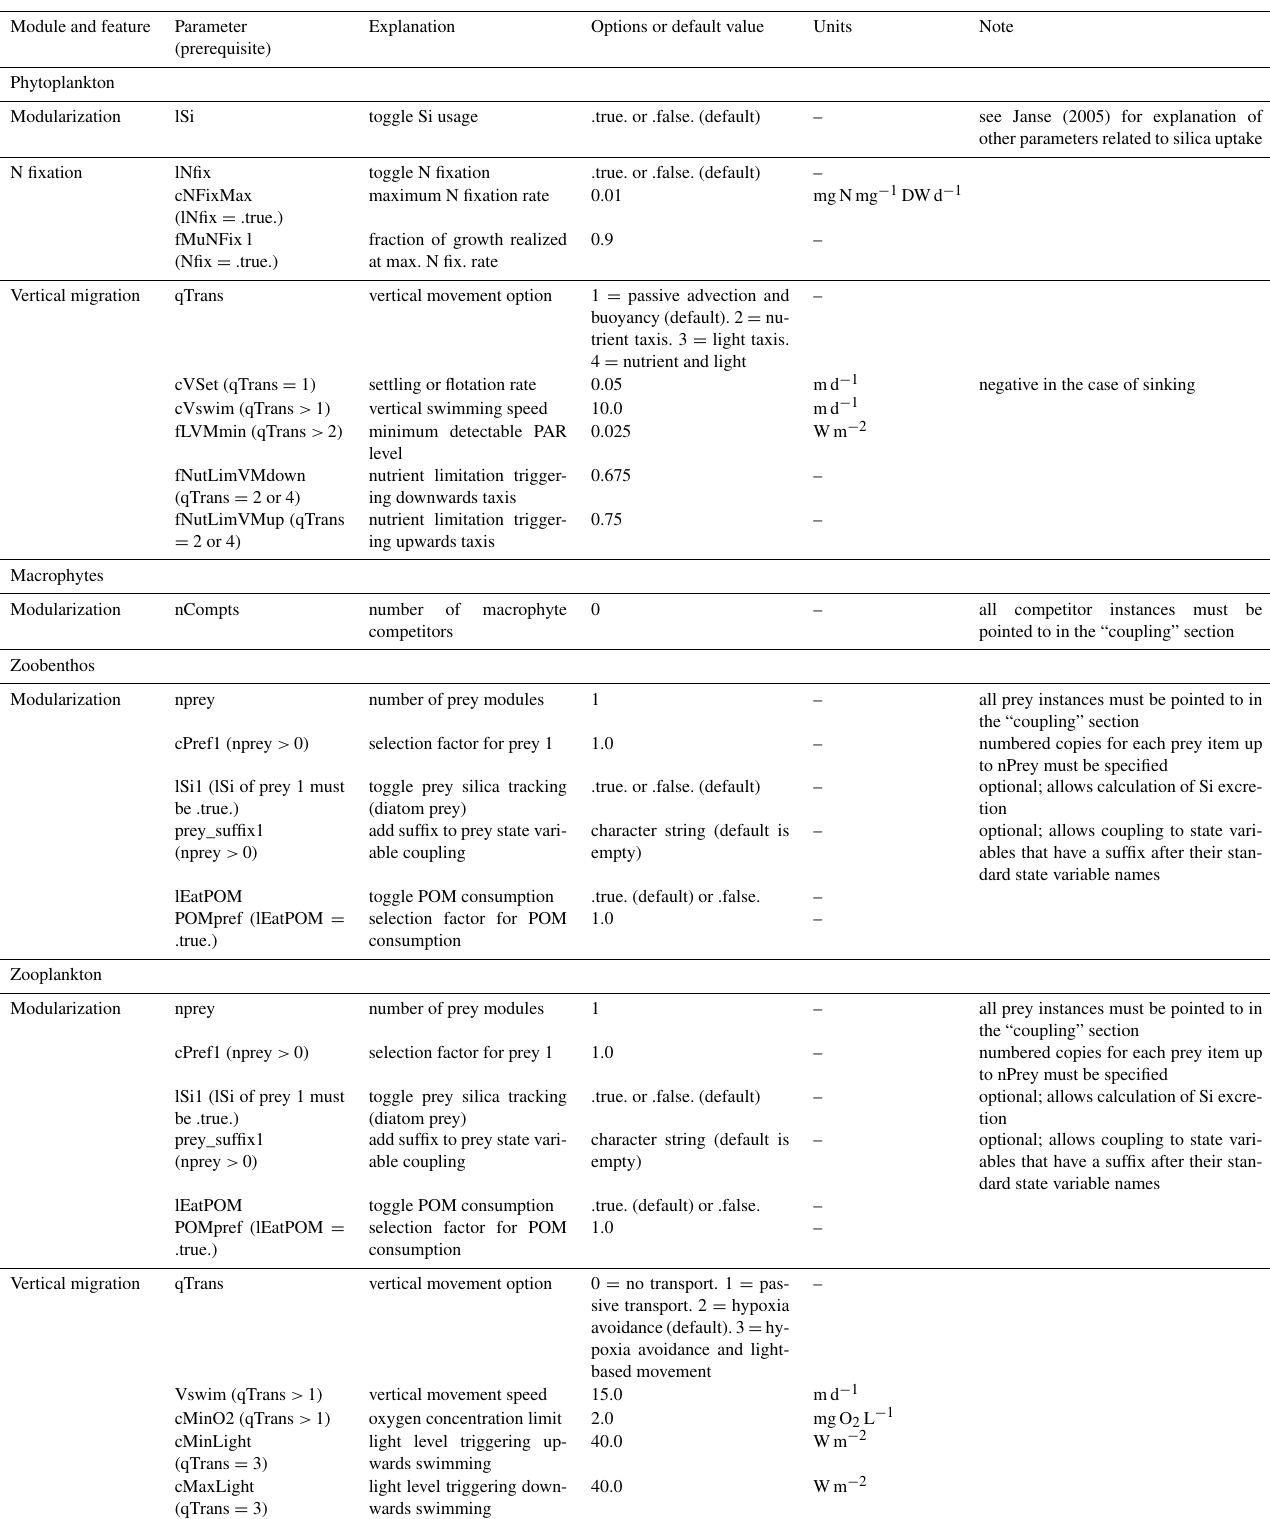
Table 1. Parameters and settings related to the new features in WET. Module and feature Parameter